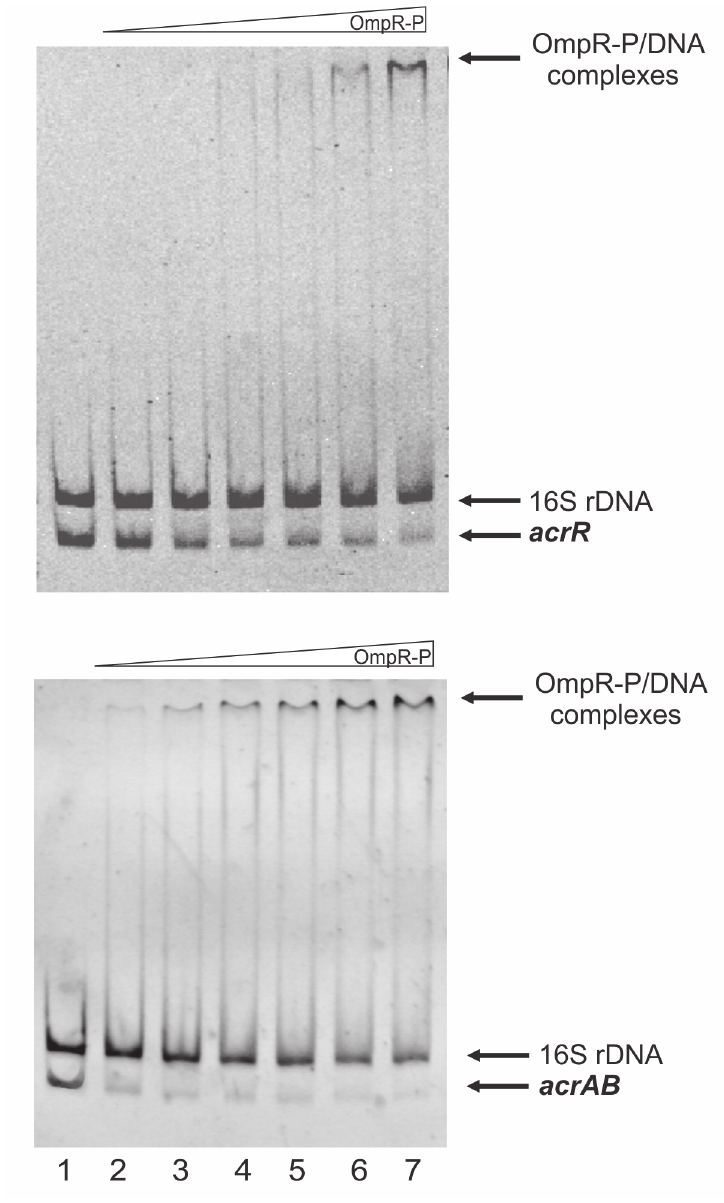
panel) promoter fragments with in vitro phosphorylated OmpR protein (lane 1 — no protein; lane 2 – 1.2 μ M; lane 3 – 2.5 μ M; lane 4 – 3.7 μ M; lane 5 – 5 μ M; lane 6 – 6.2 μ M; lane 7 – 7.5 μ M). A 16S rDNA fragment was included as a control in all reactions to confirm specific